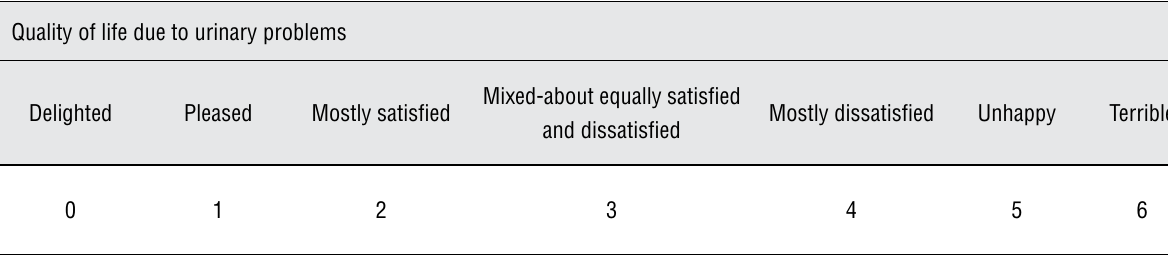
Table 1 - Assessment of quality of life in order to quantify urinary problems. Quality of life due to urinary